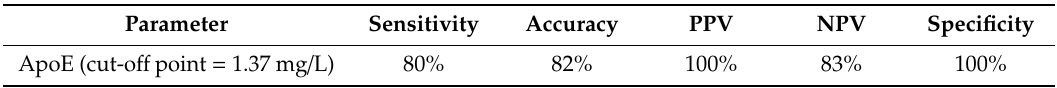
Figure 2. Receiver operating characteristic (ROC) curve for ApoE in Down syndrome (DS) screening. Table 2. Statistical parameters of ApoE measurement.